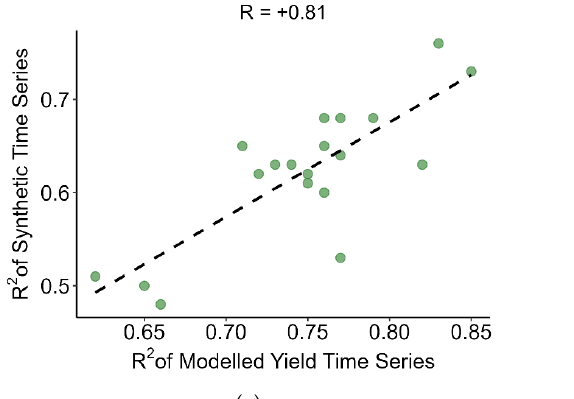
Figure 15. The correlation plots between R 2 of synthetic NDVI time series and R 2 of modelled yield time series for ( a ) WW (green) and ( b ) OSR (orange), from 2001 to 2019. The correlation coefficient refers to R (see Equation (5)).